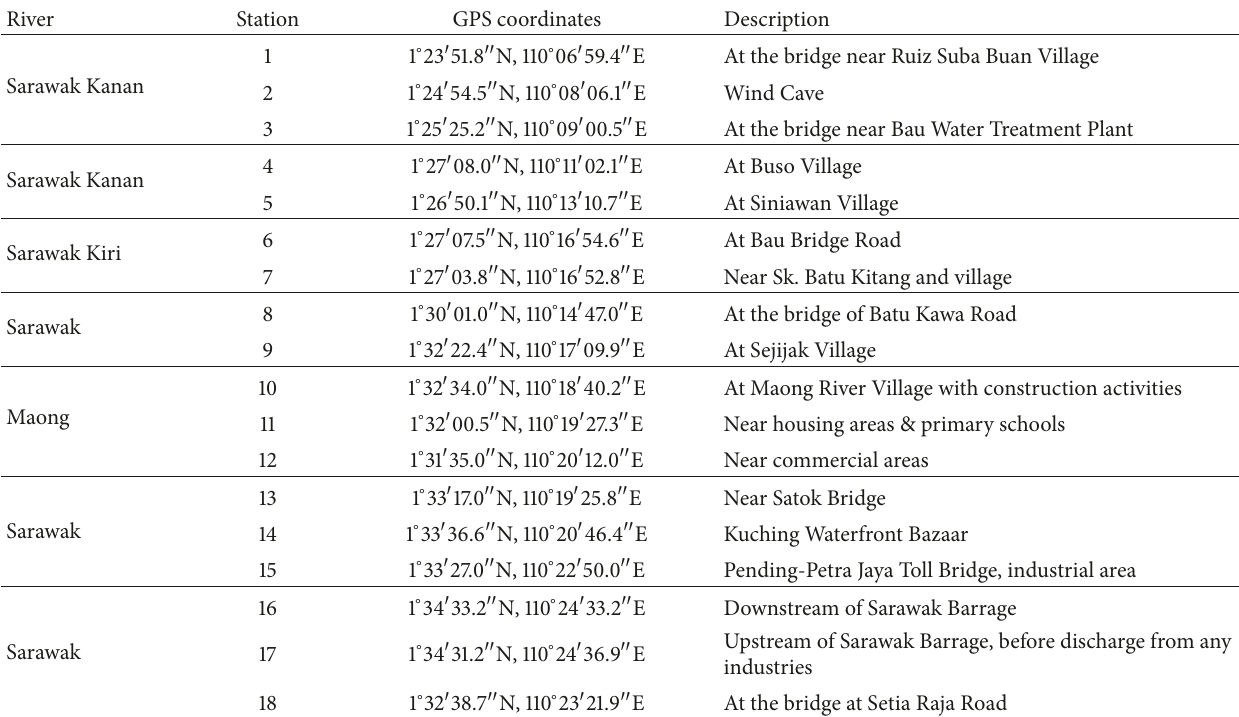
Table 1: The GPS coordinates of the sampling stations.